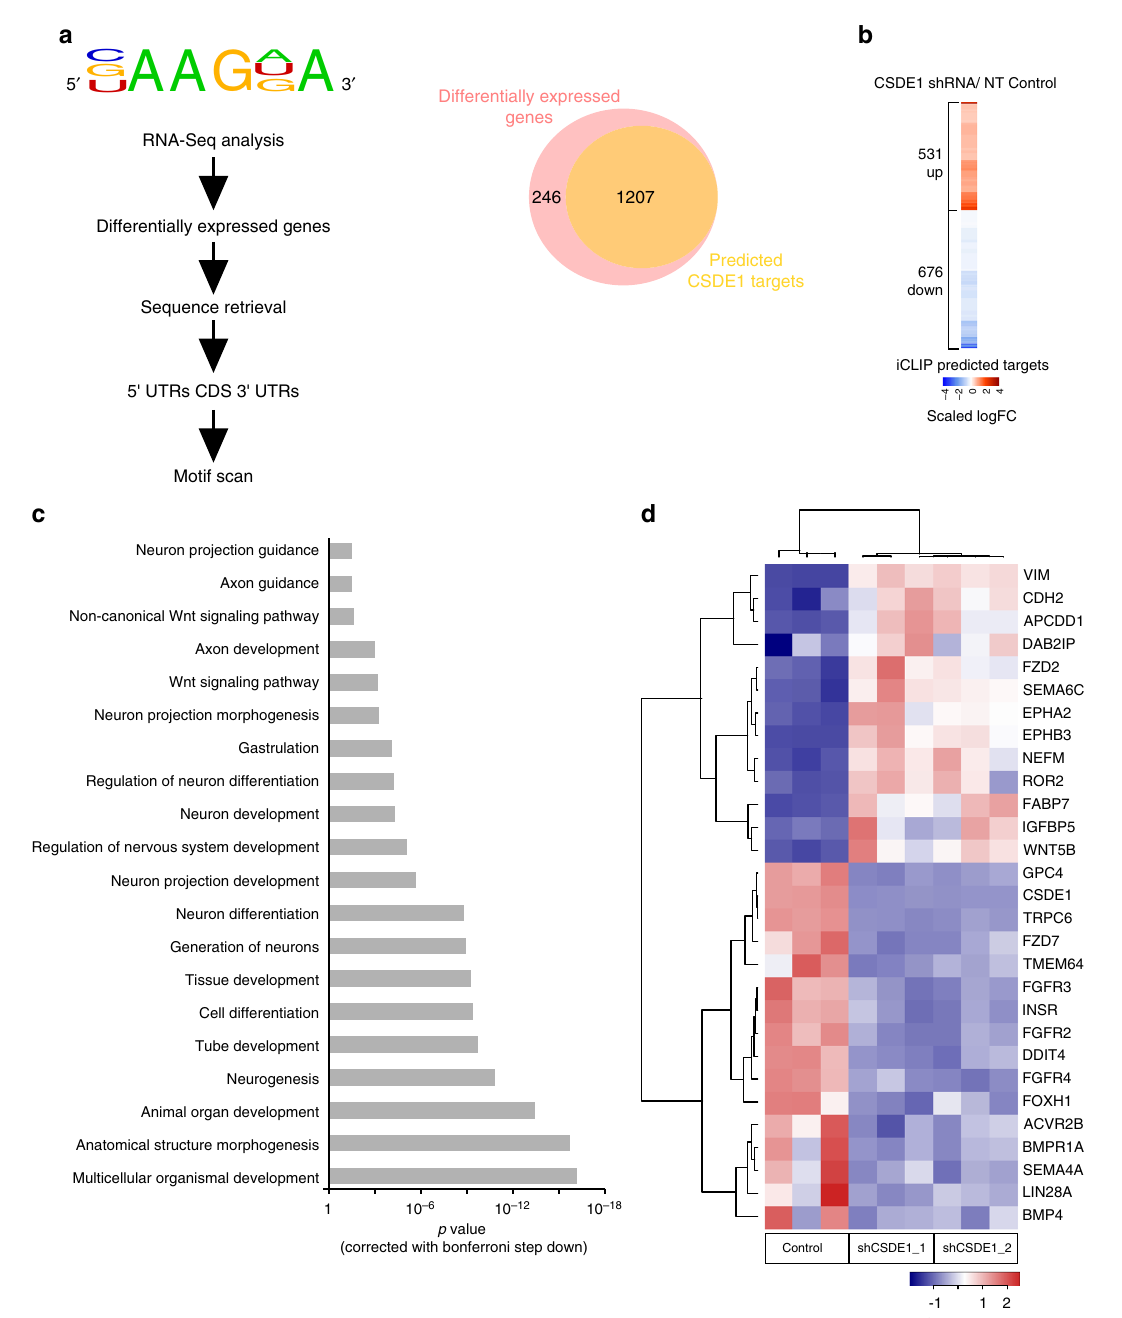
Fig. 8 CSDE1 downregulation changes the hESC transcriptome to a neural differentiation-prone state. a Schematic representation of the methodology underlying CSDE1 binding motif-based searches in differentially expressed transcripts on CSDE1 KD. Venn diagram represents the number of unique transcripts shared between differentially expressed genes from CSDE1 KD H9 hESCs and predicted CSDE1 targets. Transcripts showing a log 2 -fold change at a False Discovery Rate (FDR) < 0.05 were retained as signi fi cantly differentially expressed. b Heatmap depicting the log 2 -fold change of the differentially expressed transcripts (FDR < 0.05) with at least one CSDE1 binding site identi fi ed in CSDE1 KD hESCs by RNA-sequencing analysis. c Bar graph representing the top gene ontologies (Biological Processes) of the differentially expressed transcripts with predicted CSDE1 motif in CSDE1 KD hESCs. d Heatmap representing a subset of candidate differentially expressed genes from RNA-sequencing